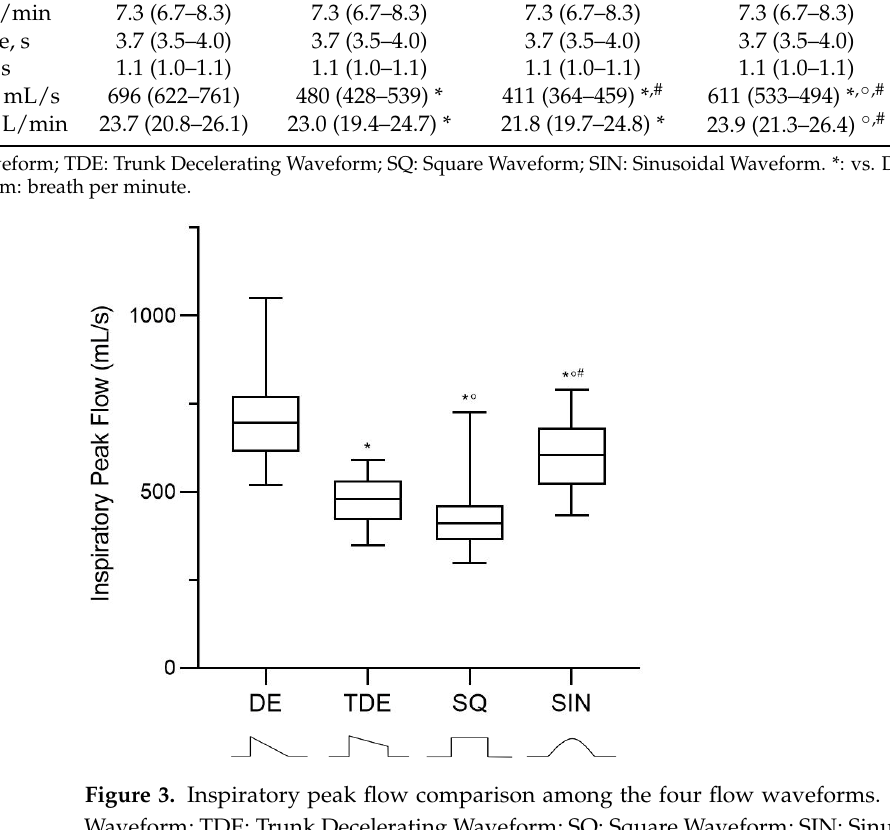
. Figure 4. Comparison of inspiratory peak and plateau pressure among the four flow waveforms. DE: Decelerating Waveform; TDE: Trunk Decelerating Waveform; SQ: Square Waveform; SIN: Sinusoidal Waveform. *: vs. DE; °: vs. TDE; #: vs. SQ. p < 0.05.